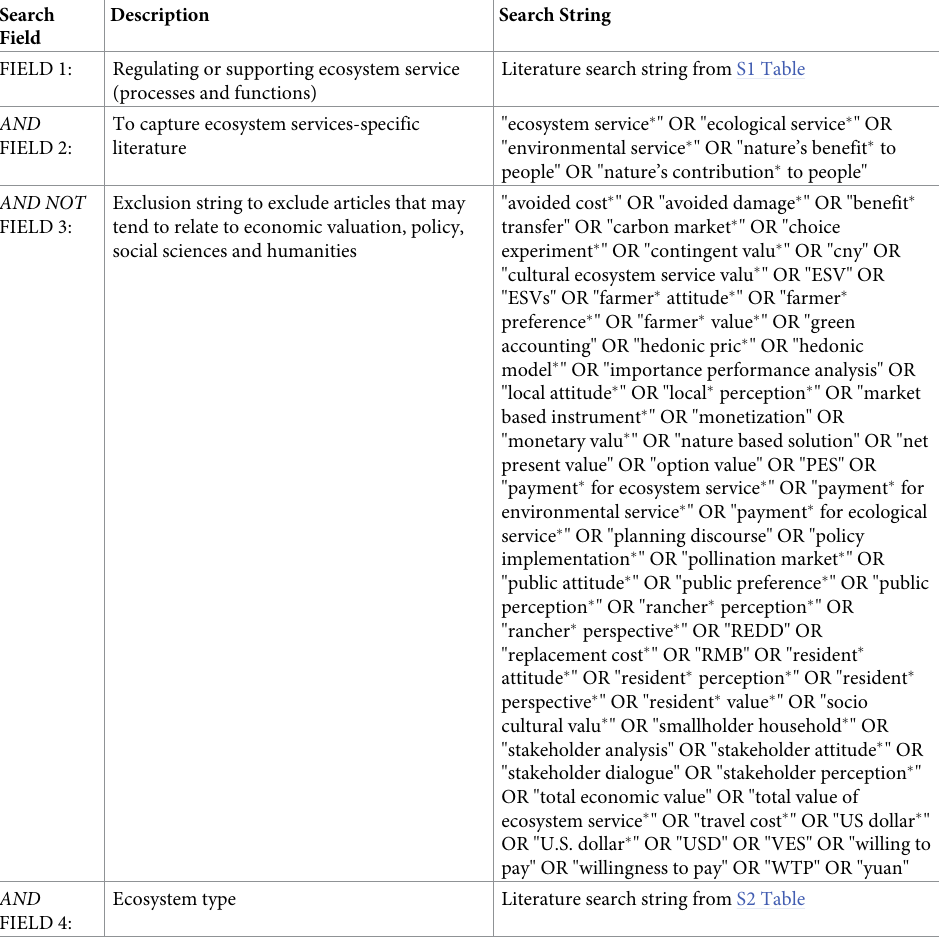
Table 1. Search fields and associated search strings for retrieving environmental science research on regulating and supporting ecosystem services from Web of Science and